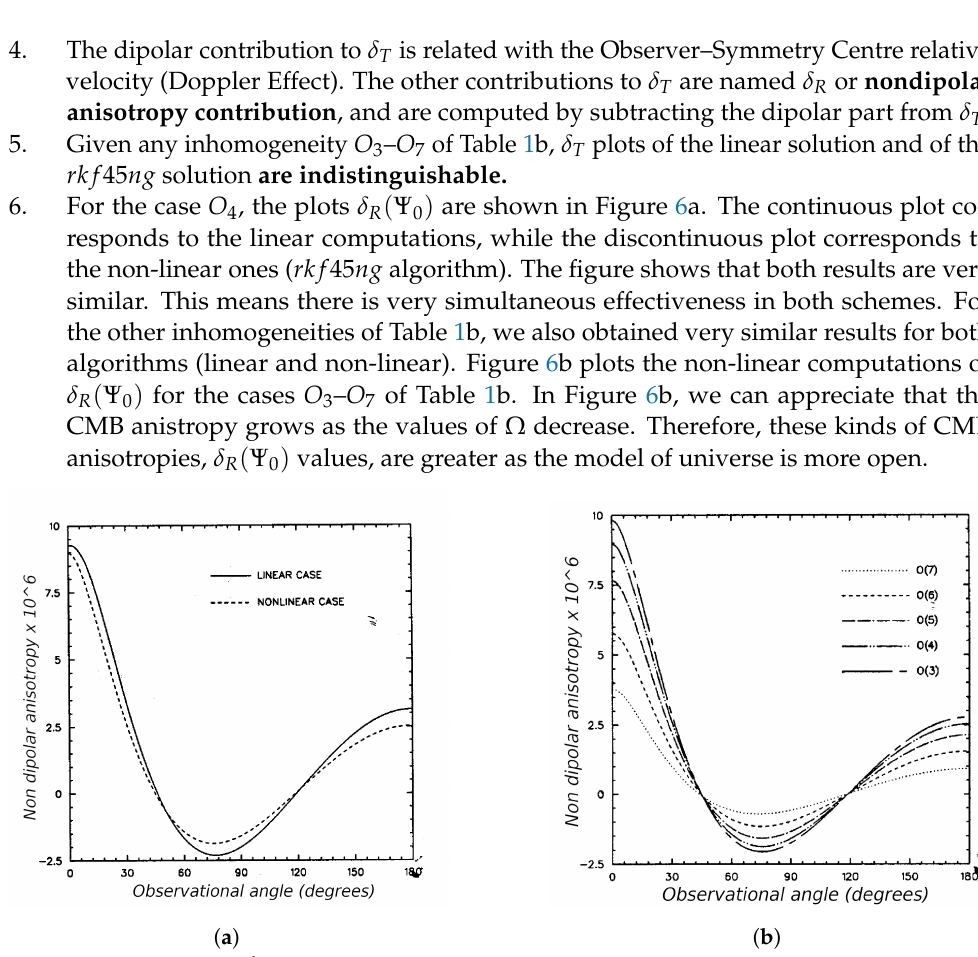
Figure 6. Plot of δ R × 10 6 as a function of the observational angle, Ψ 0 , in degrees. ( a ) Inhomogeneity O 4 . The continuous plot is the result of the linear computation. The discontinuous plot is the result of rkf 45 ng computation. ( b ) Anistopies of overdensities in universes with different Ω